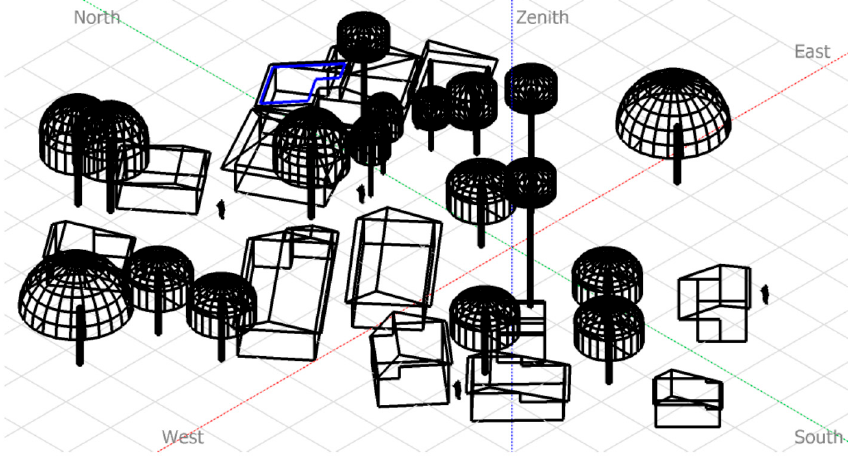
Figure 6. Perspective of the rooftop PV field and surrounding shading scene.